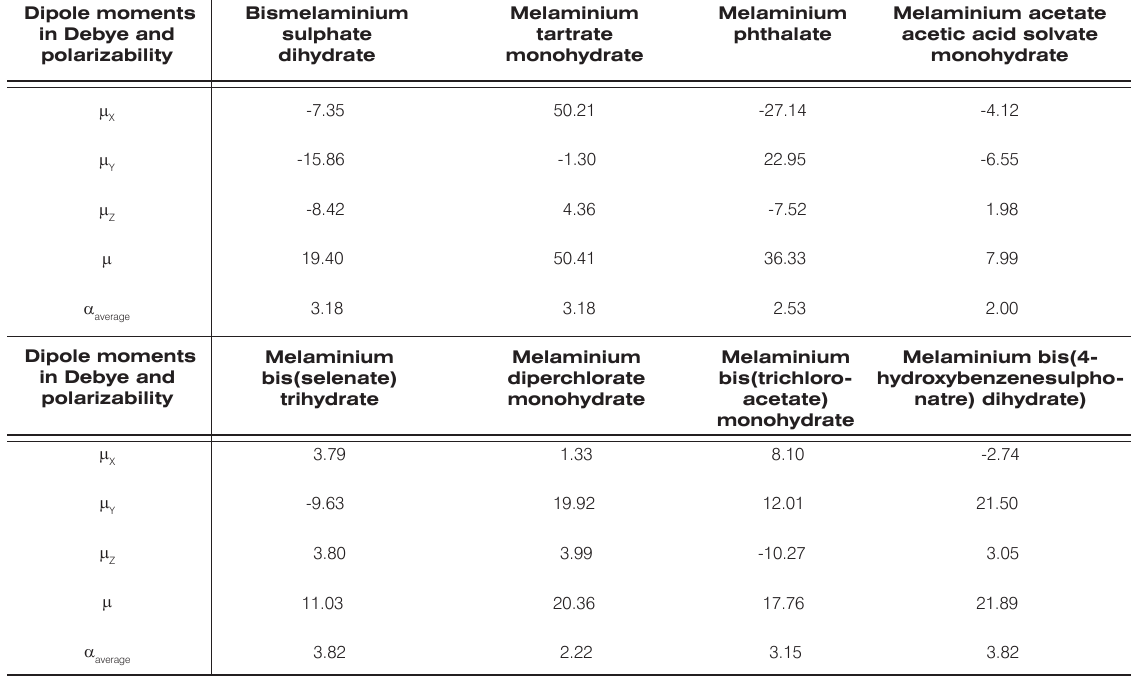
Table 1. The calculated dipole moments m [D] and polarizability a [10 9 esu cm -2 ] for investigated molecules. Dipole moments in Debye and